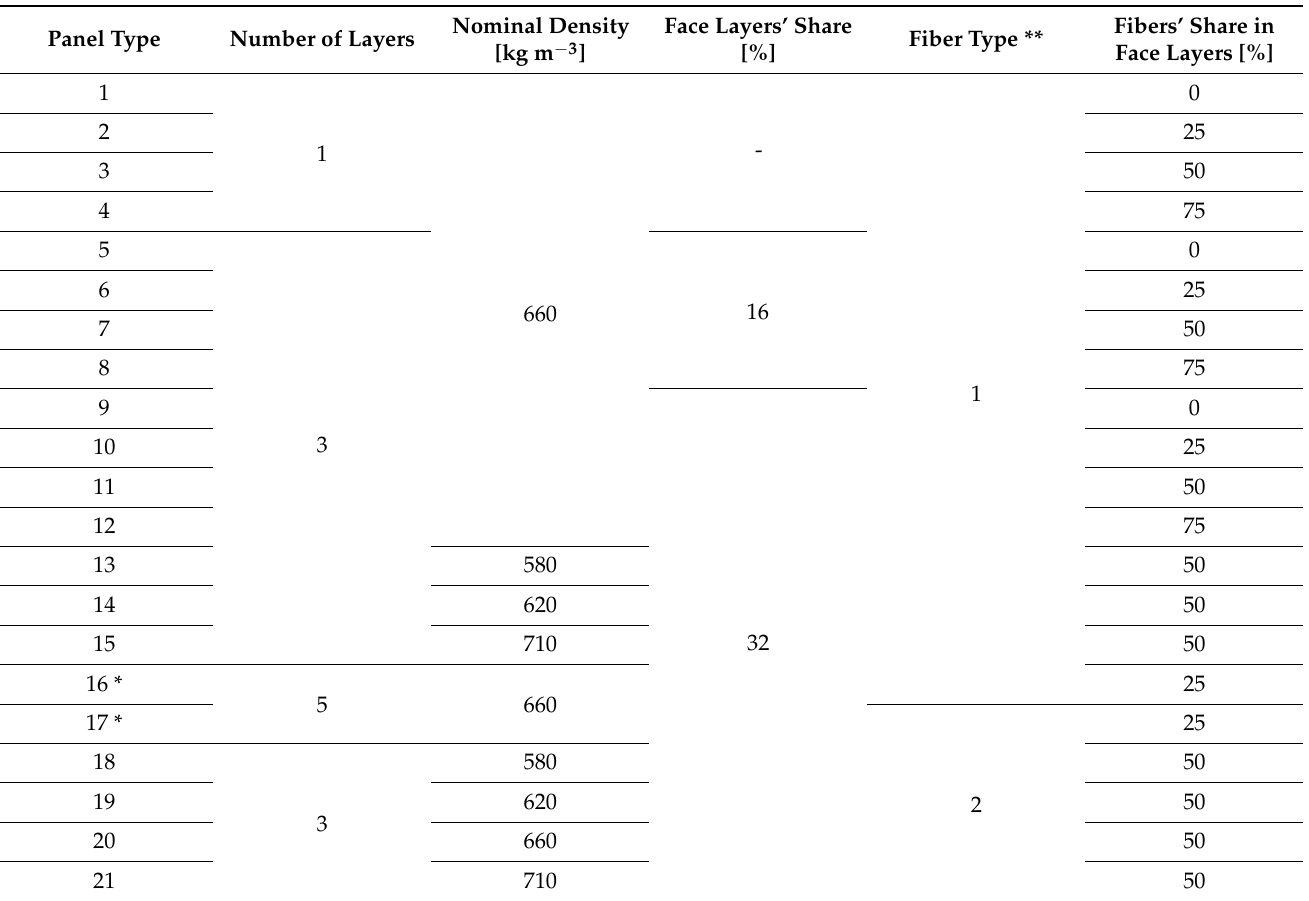
Figure 1. The morphological characteristics of the fibers.